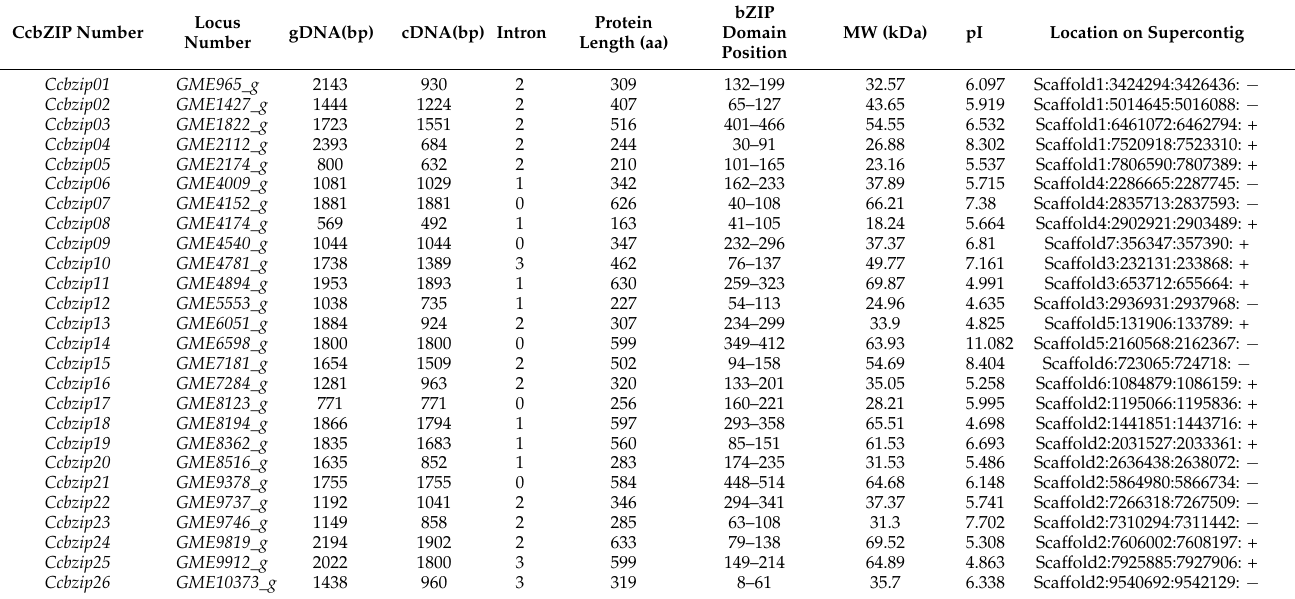
Table 1. Genes encoding CcbZIP transcription